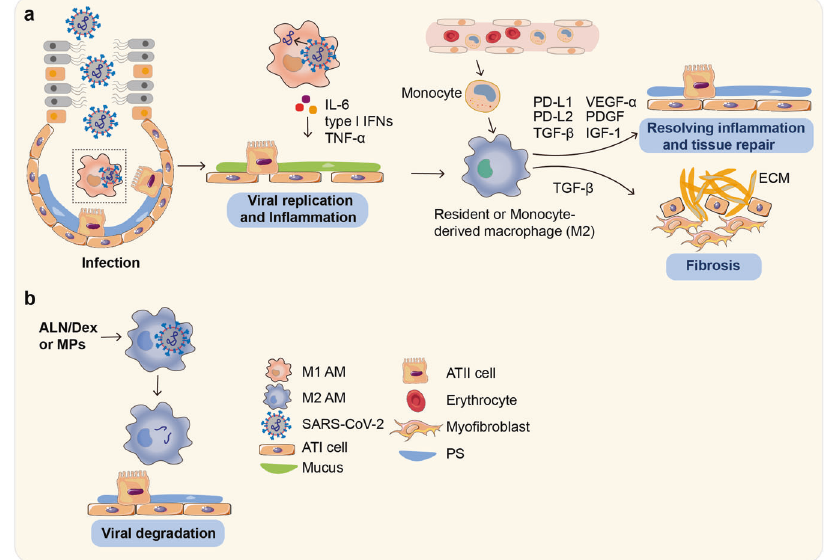
Fig. 4 M1-like and M2-like AMs involve in SARS-CoV-2 infection differently. a M1-like AMs have more acidic endosomes than M2-like AMs, leading to release of the viral RNA from endosomes into the cytoplasm for replication. Meanwhile, proin fl ammatory cytokines, including TNF- α and IL-6, are upregulated in virus-infected M1 AMs, causing lung injury. Bone marrow-derived monocytes migrate into alveoli to replenish AMs during SARS-CoV-2 infection. These cells together with resident AMs may contribute to in fl ammation. However, they can also be polarized into potential M2-like phenotype by IL-4 and IL-13 stimulation, producing a variety of factors that facilitate tissue repair and resolving in fl ammation. If the process loses its balance, undesirable repair processes can cause tissue fi brosis. b Microparticles (MPs), Alendronate (ALN), and Dexamethasone (Dex) can promote viral degradation by polarizing AMs into M2 phenotype. M2-like AMs have a higher endosomal pH, which hinders CTSL activity and subsequent viral RNA release, leading to the delivery of viruses to lysosomes for